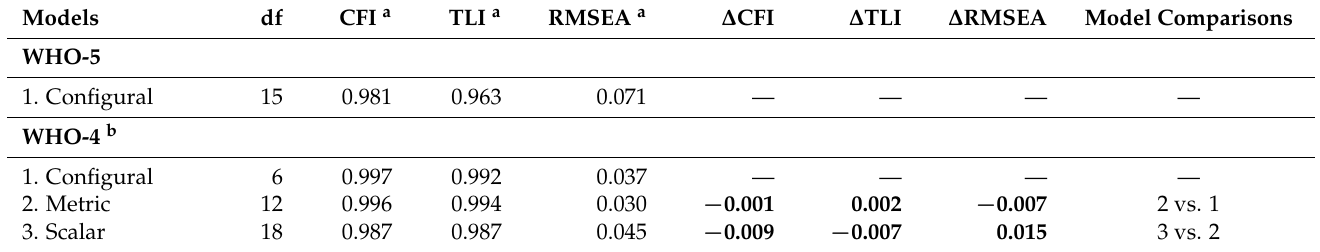
Table 5. Measurement invariance testing by age category ( N =